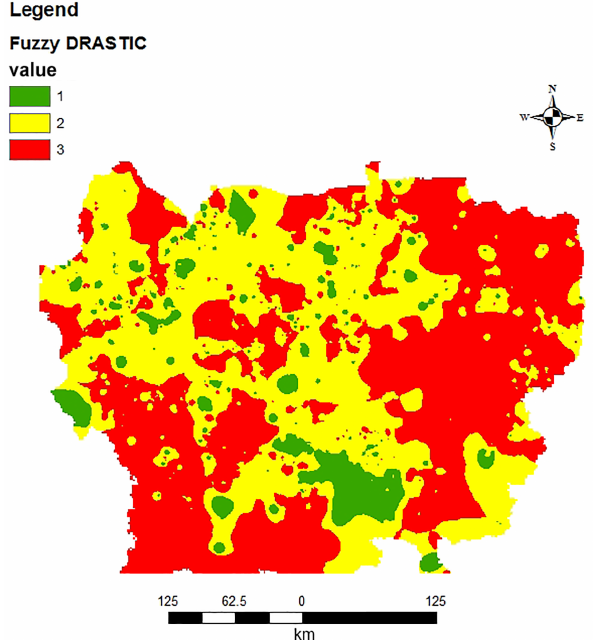
Figure 13. Fuzzy DRASTIC vulnerability map.